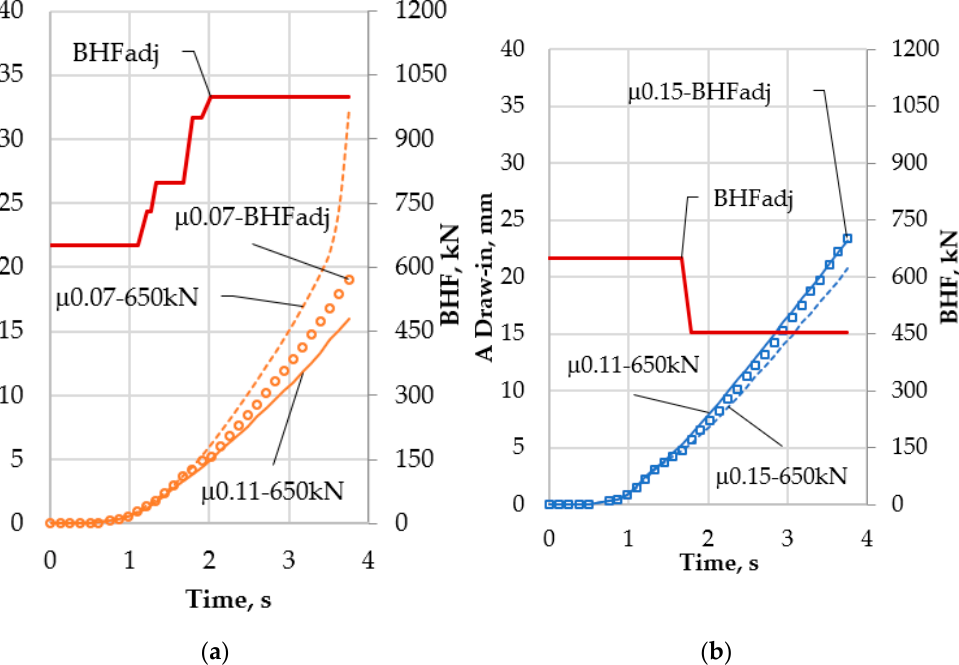
Figure 20. Draw-in curves and BHF adjusted in the controlled sensor with a friction coefficient equal to ( a ) 0.07 and ( b ) 0.15.